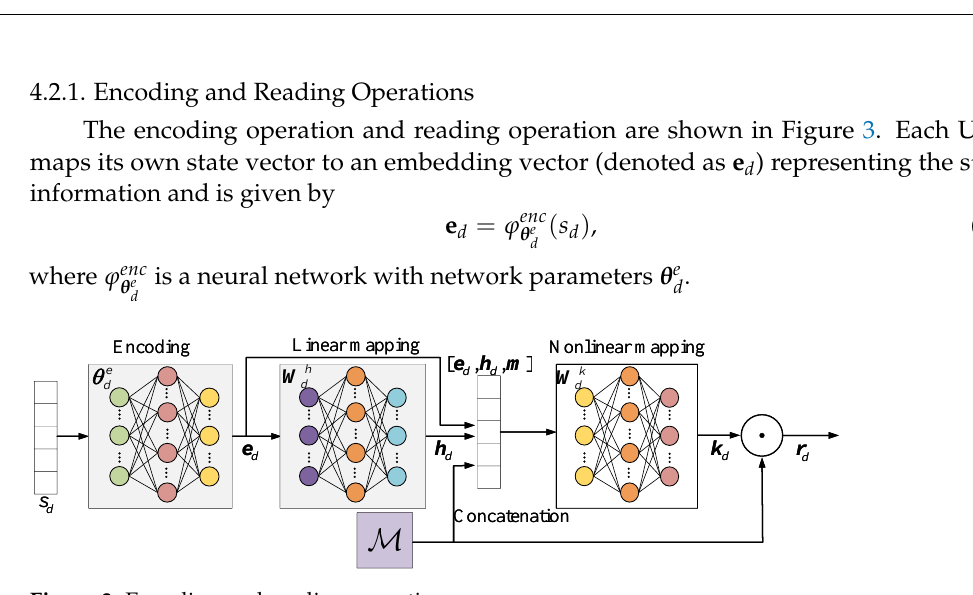
Figure 3. Encoding and reading